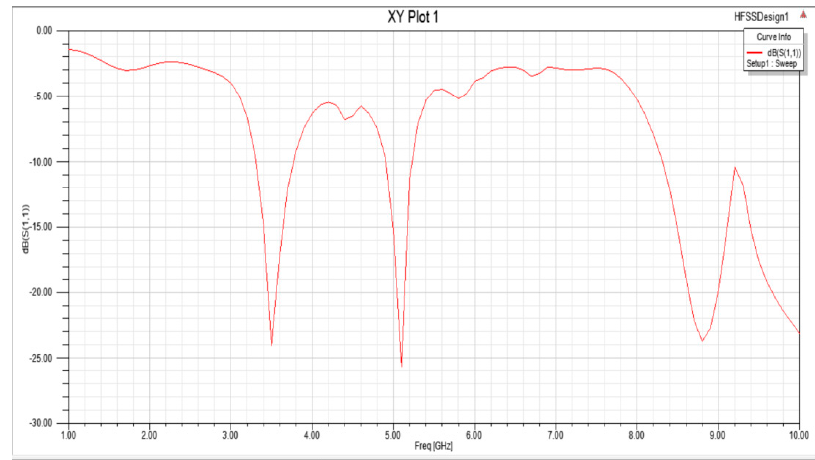
Figure 13. S11 plot of multi-stacked DRA.